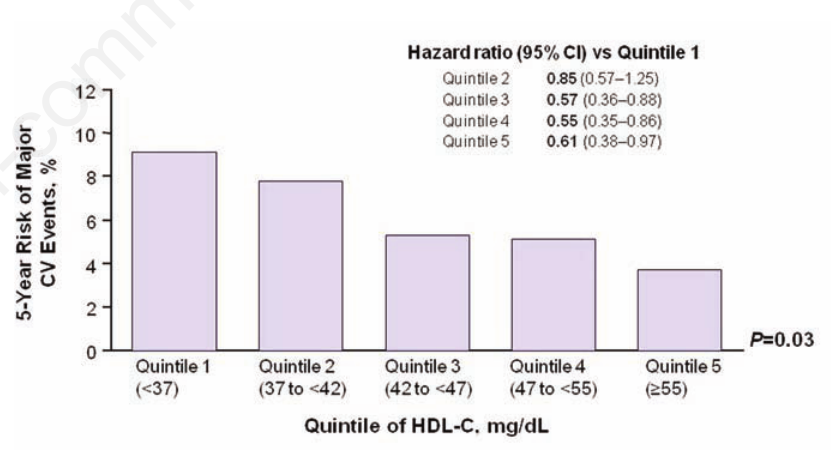
Figure 3. A post-hoc analysis of the TNT trial showing that high levels of high-density lipoprotein-cholesterol (HDL-C) significantly reduced the 5-year risk of major CV events, even in patients with low-density lipoprotein-cholesterol (LDL-C) (<70 mg/dL). Using multivariate analysis, the authors explored whether HDL-C levels are clinically relevant in patients who achieve the LDL-C goal of <70 mg/dL for very–high-risk patients. Analysis of the TNT data showed that as HDL-C values increased from quintile 1 to quintile 5, there were significant reductions in the occurrence of major CV events in this cohort of statin-treated patients with LDL-C <70 mg/dL. Notably, the risk of major CV events was 39% lower among patients in the highest HDL-C quintile (HDL-C ≥55 mg/dL) compared with patients in the lowest HDL-C quintile (<37 mg/dL).The finding that HDL-C remained a significant predictor of major CV events in patients with very- low LDL-C supports the clinical relevance of HDL-C as a therapeutic target. Statin- treated patients who achieve a low LDL-C goal still have a substantial residual risk that can perhaps be reduced by increasing the HDL-C